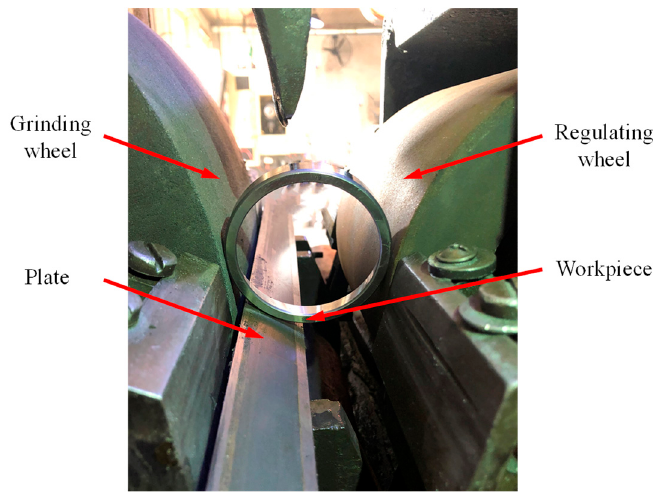
Figure 1. Experimental device.